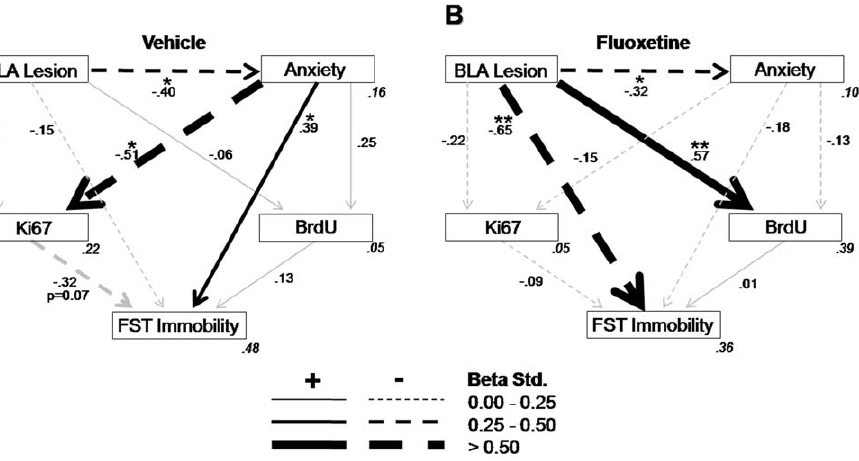
Figure 6. Path analysis for the models according to the drug treatment groups. A. Model fit was tested separately for the vehicle group ( x 2 =0.07, df=1, p=0.784; CFI=1.00; RMSEA , 0.01, p=0.791) and B. for the fluoxetine group ( x 2 =2.00, df=1, p=0.157; CFI=0.94; RMSEA=0.17, p=0.175). Significant paths (p , 0.05; **p , 0.01) are in black and non significant in gray. The squared multiple correlations ( R 2 ) of the endogenous variables are located in their right inferior corner in gray and